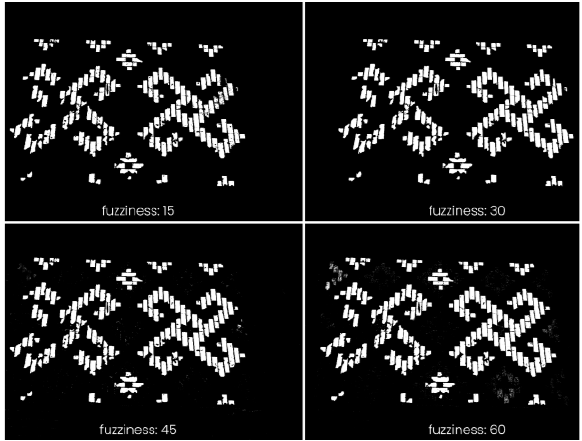
Figure 2. Colour range selection with different values of fuzziness for turquoise-coloured bricks in Sırçalı